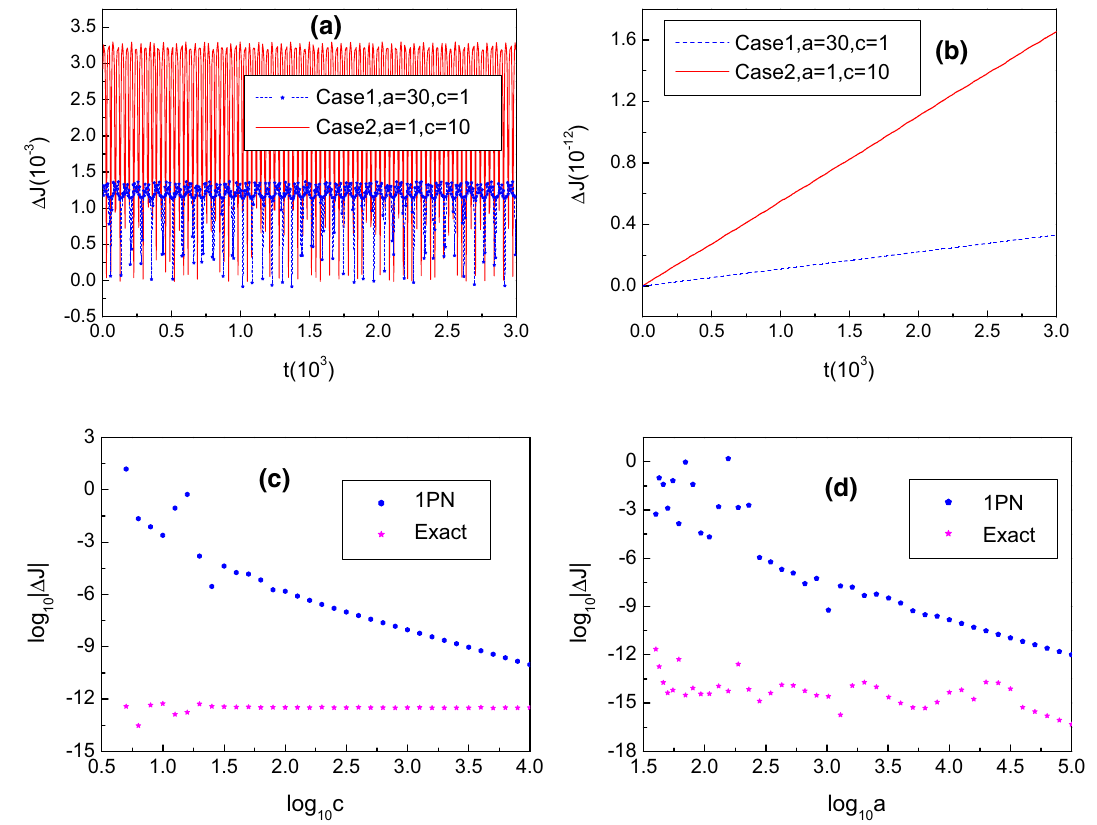
Fig. 2 Conservation of the Jacobian constant J by Orbit 1: a the 1PN truncated system; b the exact system; c the dependence of errors on c with a = 1; d the dependence of errors on a with c = 1 (cid:13) c = 1 /ε ≈ 1 . 0067 × 10 4